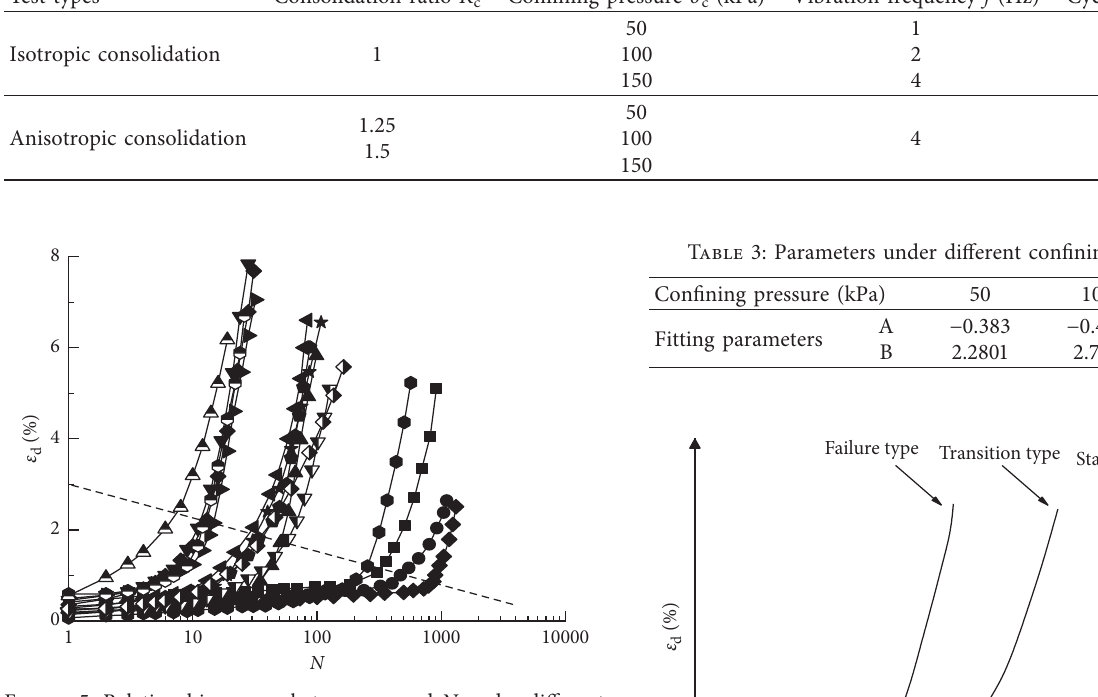
d and N under different